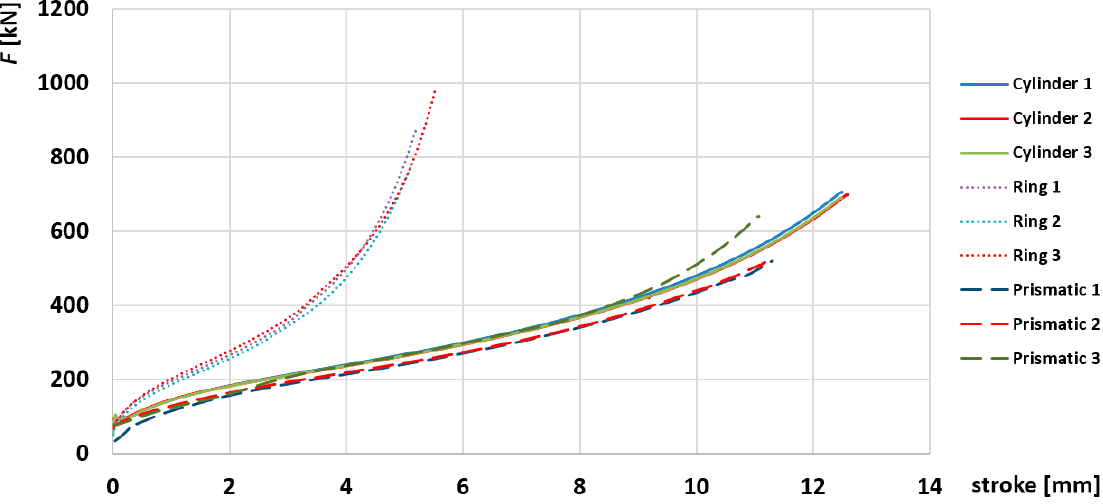
Figure 7. Compression force for all three specimen groups.